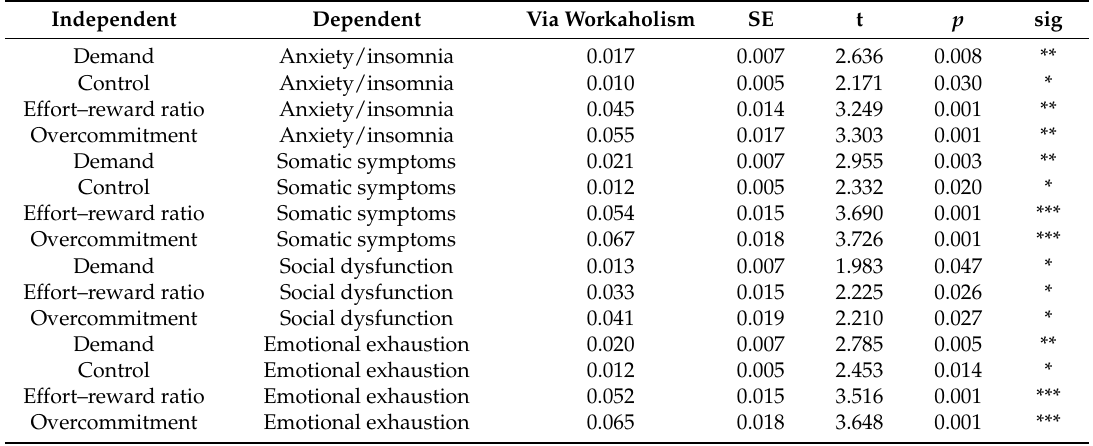
Table 4. Statistically significant indirect paths (independent *